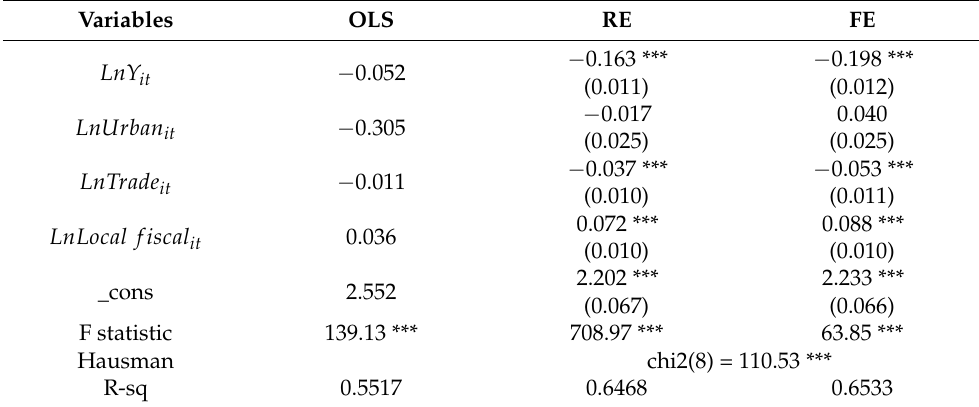
Table 3. Analysis of the overall poverty reduction